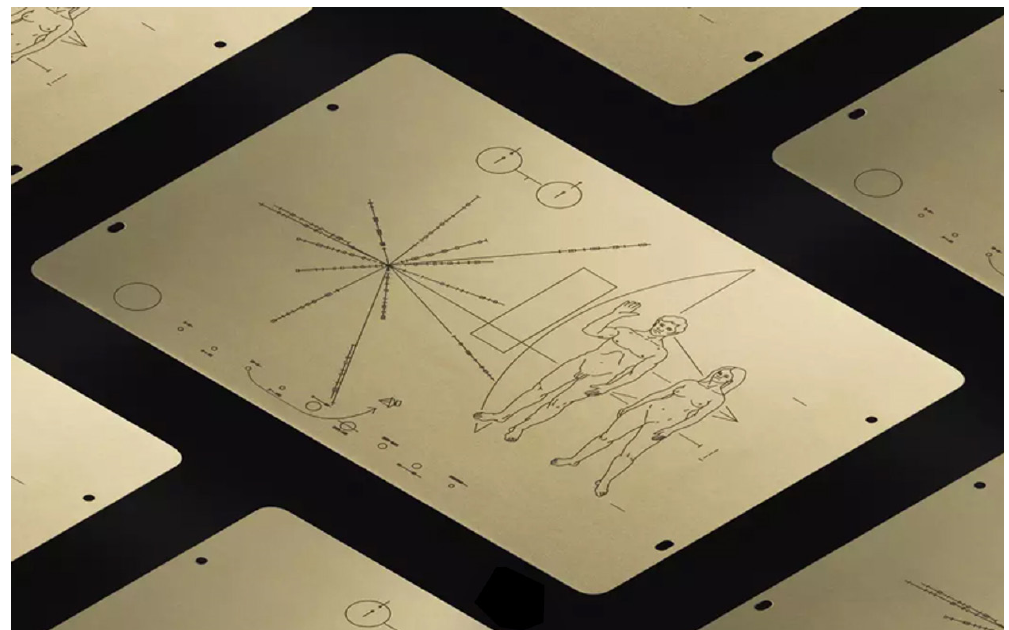
Fig. 1 Plaque applied to the Pioneer F space probe and sent into space,